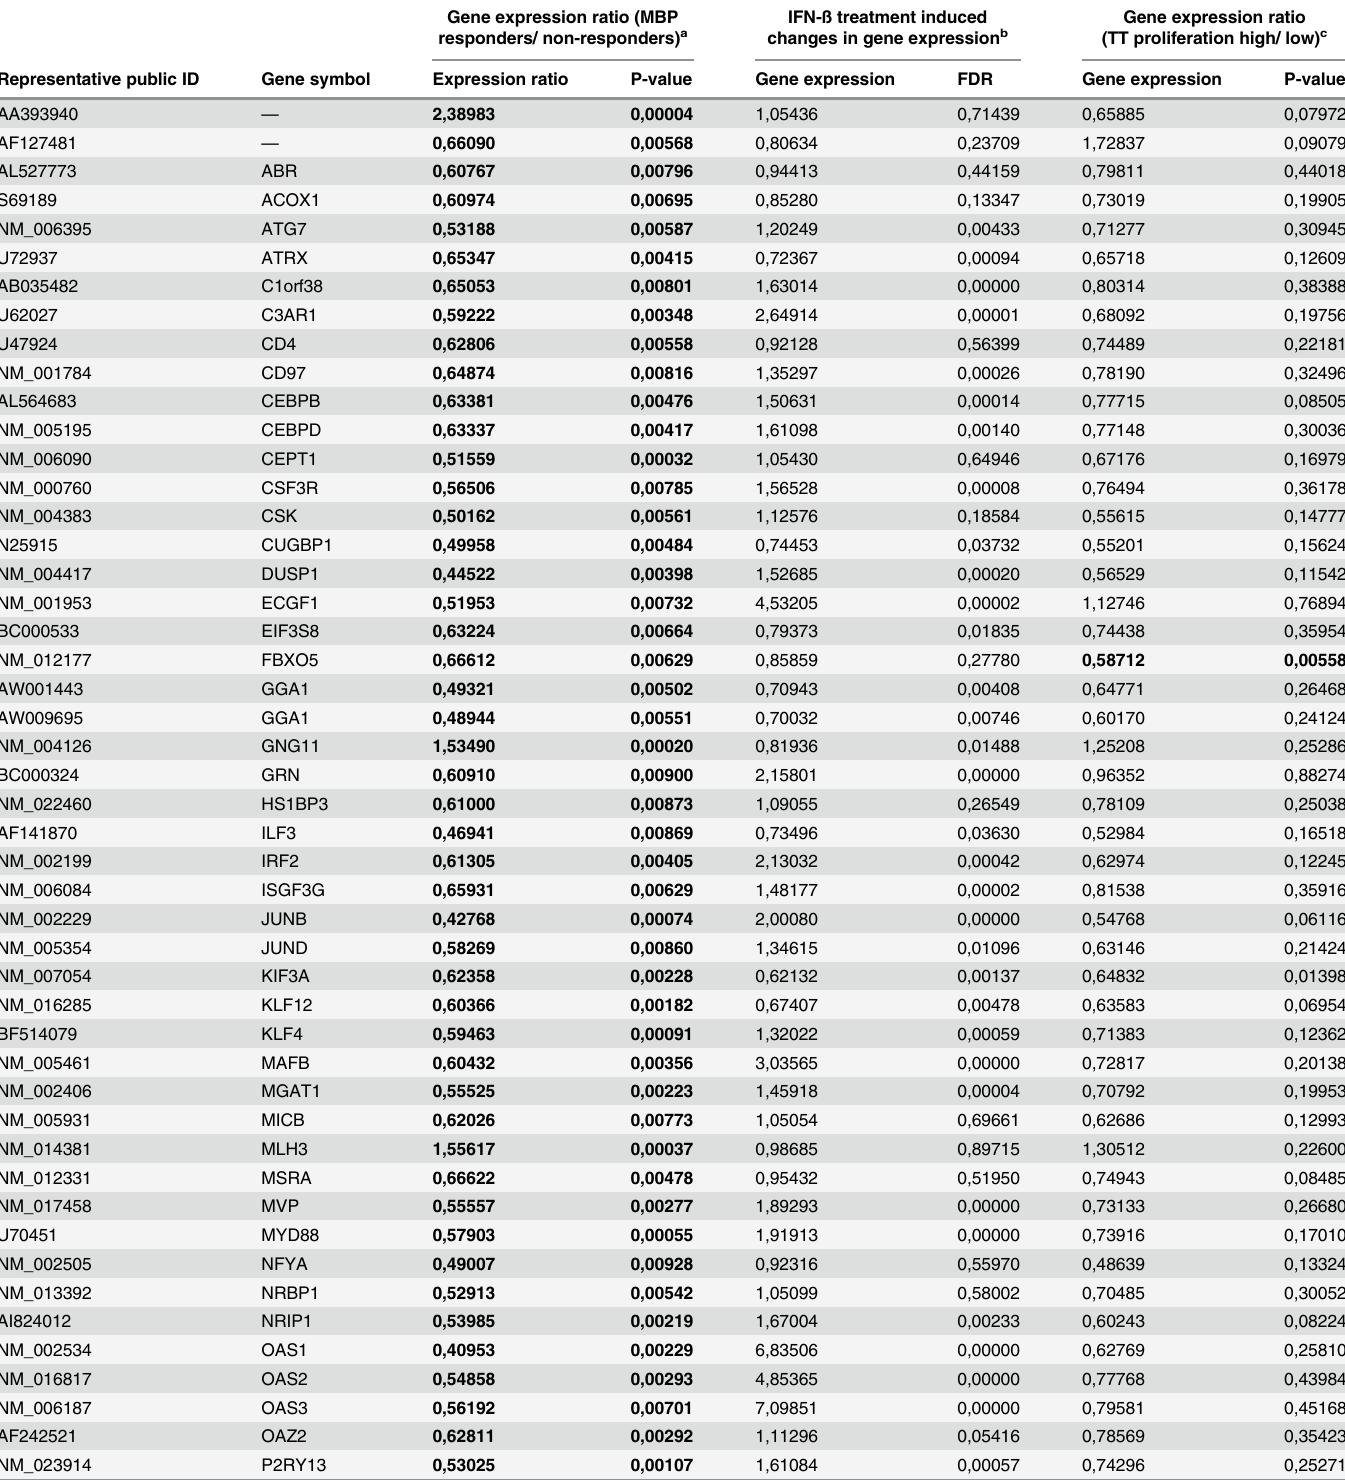
Table 2. Association between endogenous expression of IFN- β -inducible genes in peripheral blood mononuclear cells with T-cell reactivity to myelin basic protein (MBP) and tetanus toxoid (TT) in untreated MS patients.